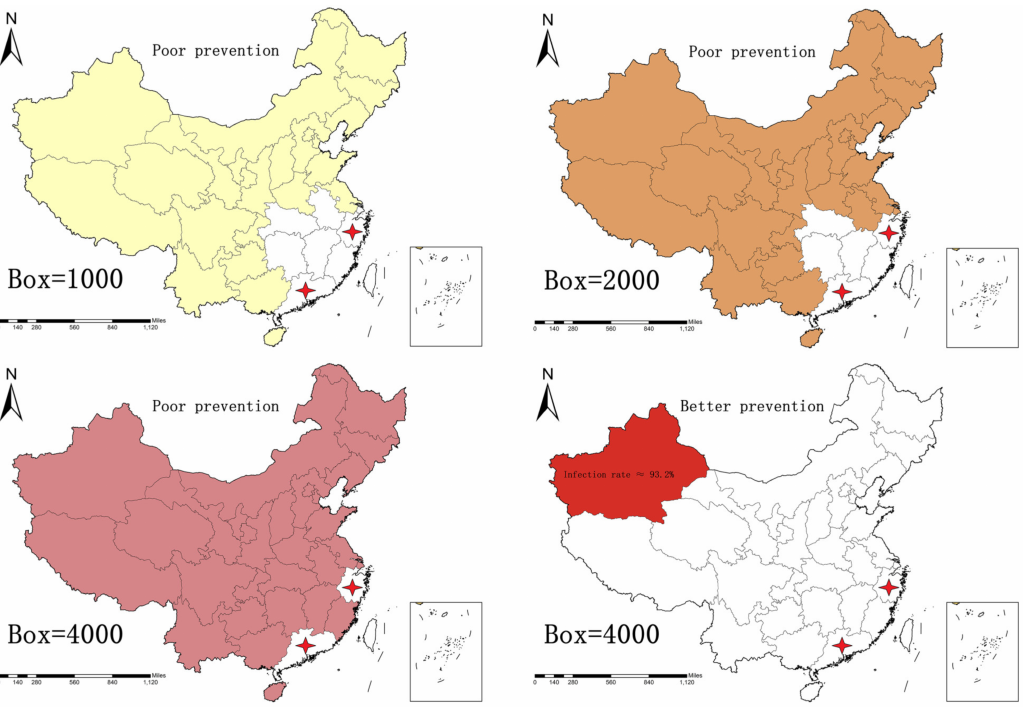
Figure 7. Spatial-geographic influence of the number of express boxes on the transmission of the virus (the first three are the most suitable environment for virus transmission. The last one is the unsuitable environment for virus